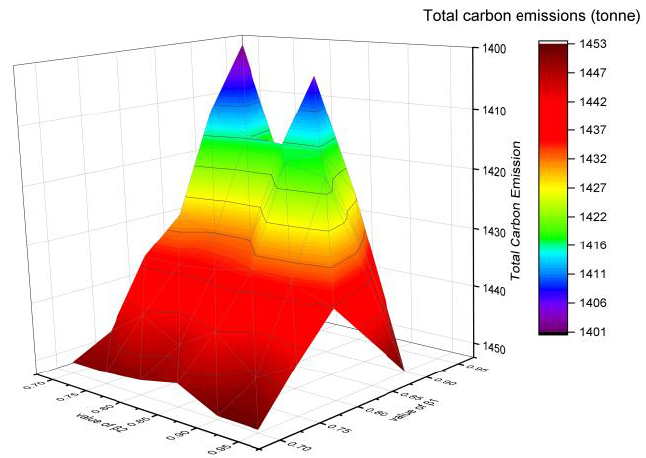
Figure 10. Carbon emissions versus values of β 1 and β 2.